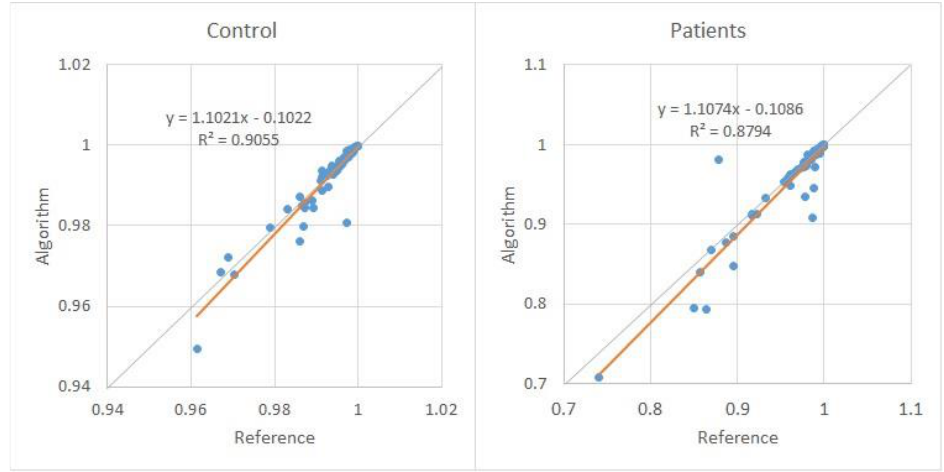
Figure 5. Comparison of Autocorrelation values for the 90 control measurements (left-hand side) and 90 patient measurements (right-hand side).